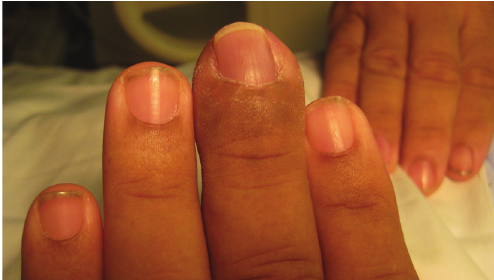
Figure 1: A swollen, painful tip of the left third finger.